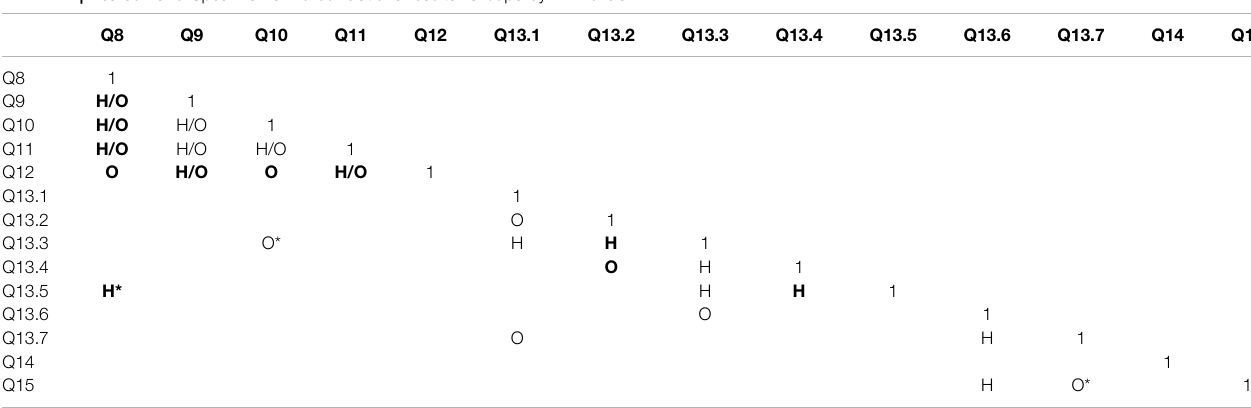
TABLE 4 | Pearson and Spearman ’ s rho correlations results. Groups by HDI